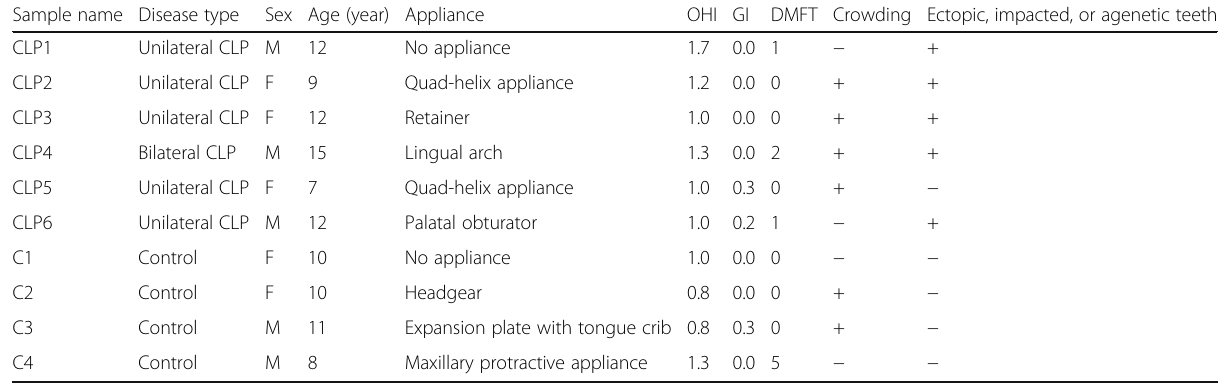
Table 1 Clinical characteristics of the study participants Sample name Disease